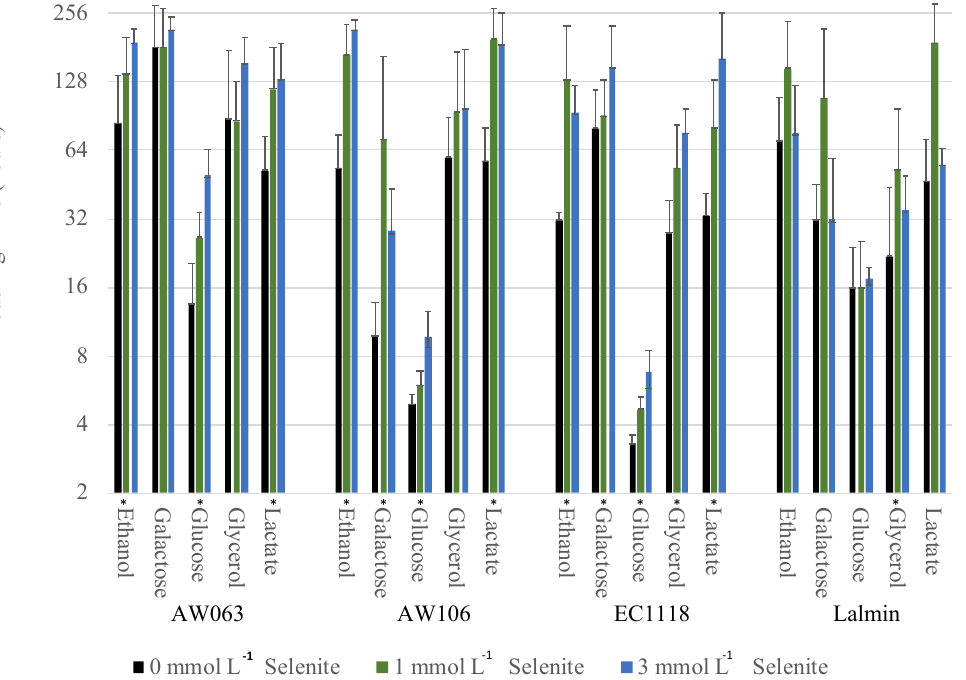
Figure 2. Selenite resistance dependence on carbon source. Strains were grown overnight in synthetic complete medium, then inoculated into medium containing the indicated carbon source and the indicated concentration of selenite. Growth rate was monitored for 48 h, and maximal growth rate (doubling time) was determined as described in methods. Doubling times are displayed on a logarithmic scale. Asterisk above carbon source label indicates a significant difference ( p < 0.05) in doubling time between 0 and 3 mmol L −1 conditions.